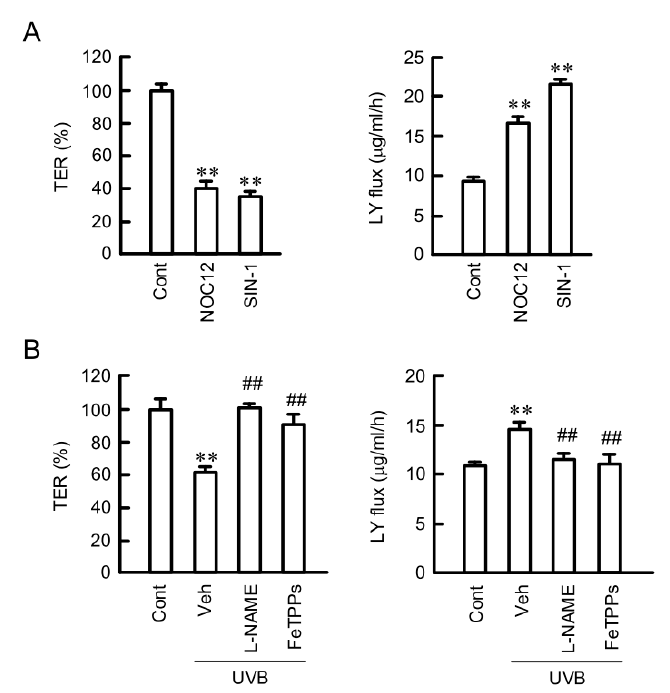
Figure 6. Involvement of RNS in the UVB-induced destruction of TJ. ( A ) Cells were incubated for 6 h in the absence (Cont) and presence of 10 µ M NOC12 or 250 µ M SIN-1. ( B ) After exposing to weak UVB, the cells were incubated for 6 h in the absence (Veh) and presence of 100 µ M L-NAME or 5 µ M FeTPPs. TER was measured using a volt-ohmmeter and represented as a percentage of the value of control (Cont). Paracellular LY flux was analyzed using a fluorescence spectrometry. n = 6. ** p < 0.01 vs. Cont. ## p < 0.01 vs. Veh.